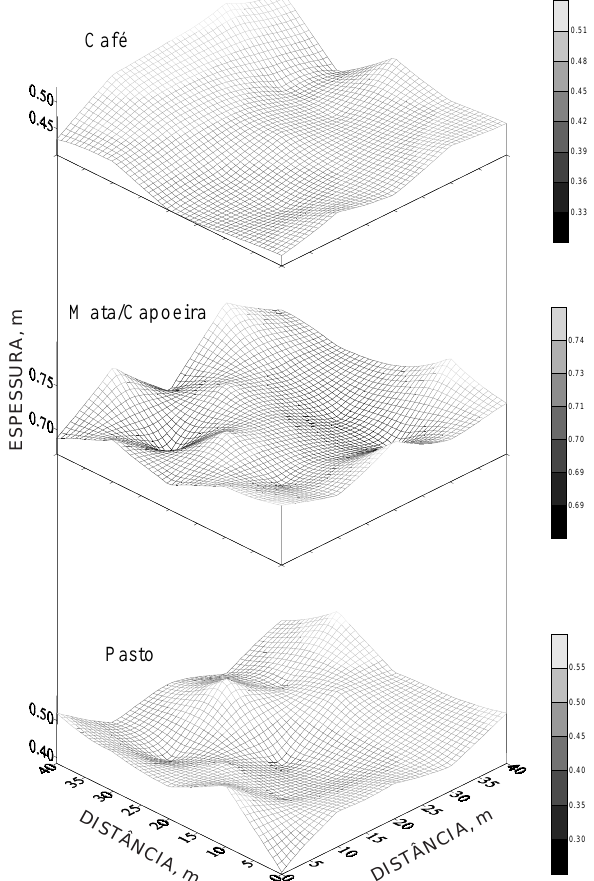
Figura 1. Mapa tridimensional da espessura do horizonte A, nos cultivos de café e pastagem e na